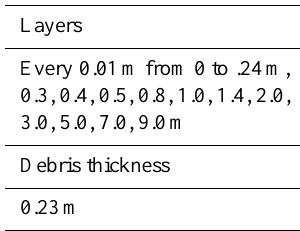
Table 2. Subsurface layer distribution and debris thickness used in this study.